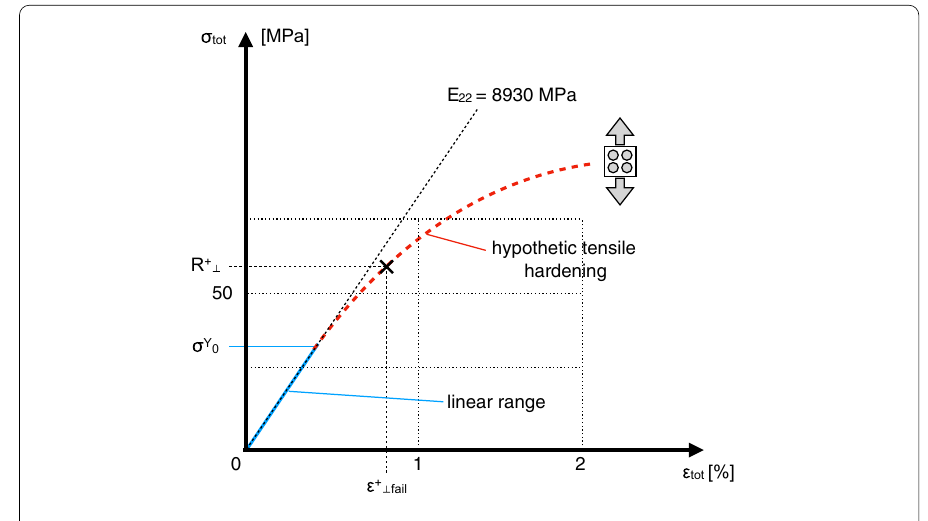
Fig. 8 Nonlinear stress–strain curve for transverse tension